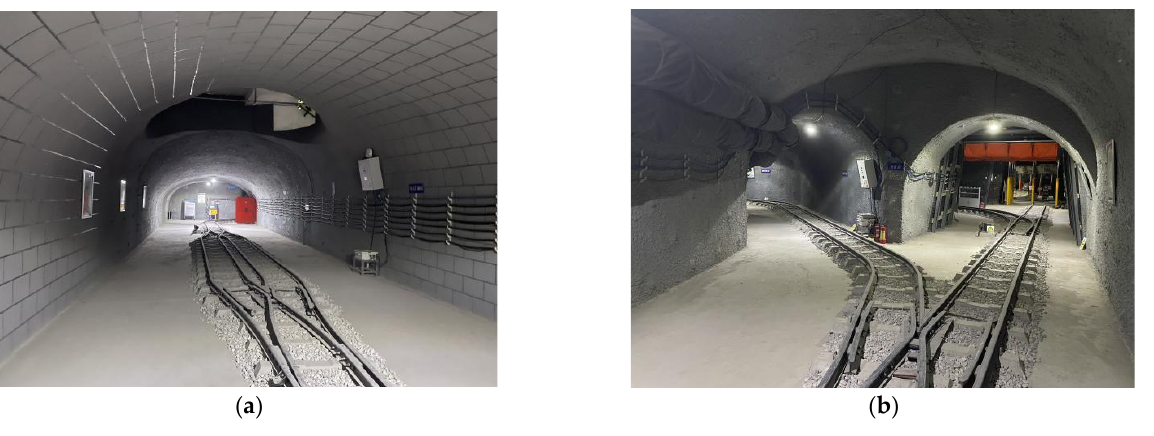
Figure 8. Partial environment of coal mine roadway. ( a ) Coal mine roadway; ( b ) Coal mine multi- roadway intersection.